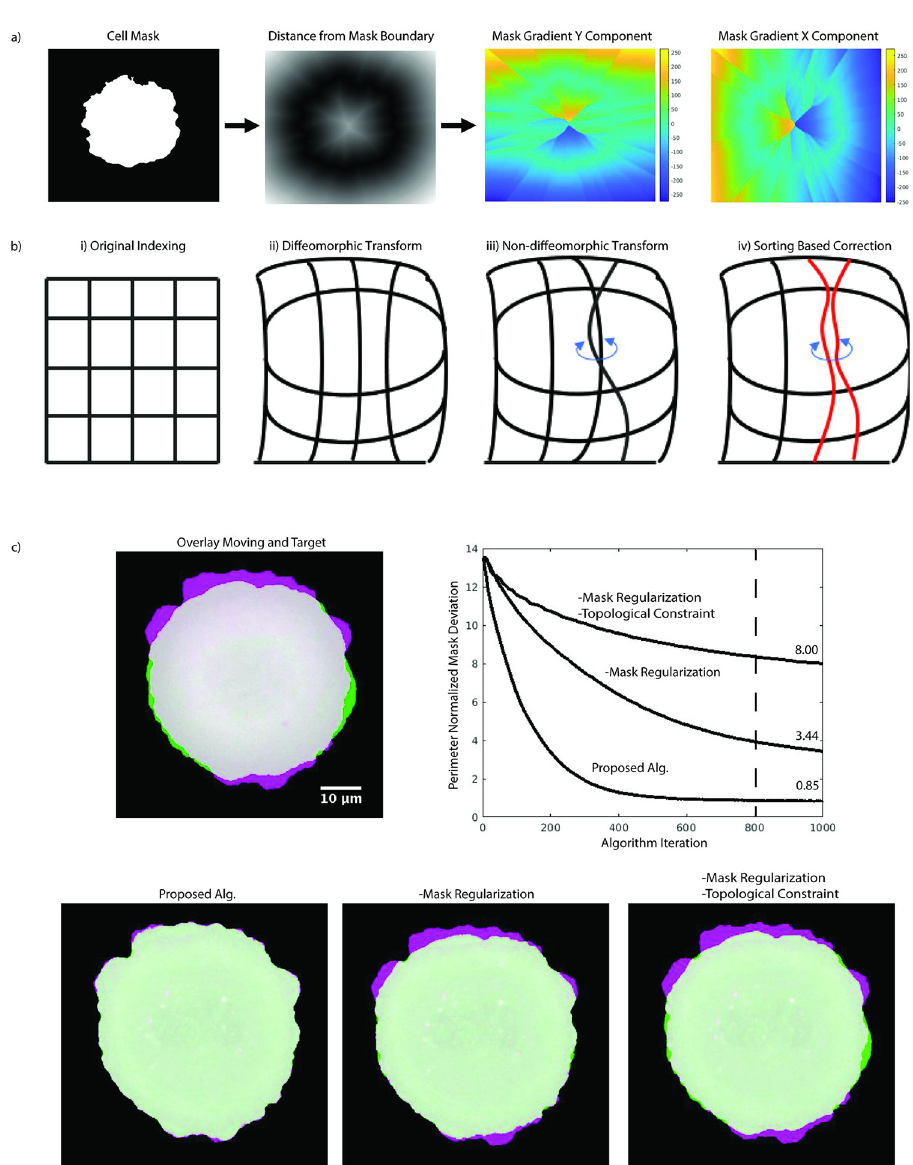
Fig 2. Computational elements for the remapping process. a) Extraction of the mask gradient r f mask . Based on a cell mask, we calculate for each pixel the distance to the nearest cell boundary element for both the cell-interior and cell- exterior spaces. The gradient on this distance field defines r f mask . b) Diffeomorphism constraint. From left to right, illustrations of interpolation fields, where edges indicate the sampling position of an input image to remap onto a target. The mesh diagram shows displacements as deviation from a square mesh (1 st diagram from left). A diffeomorphic transform (2 nd diagram) is represented by a deformed mesh. A break in diffeomorphism (3 rd diagram) is represented by crossings of mesh edges. By sorting the mesh coordinates in sequential order, breaks in diffeomorphism can be reverted (4 th diagram). c) Effect of algorithm components on cell edge registration. Accuracy of registration over n iterations is indicated by the area of mismatch (green and purple) between the moving cell and the target cell image, normalized by the target cell perimeter. Removing the mask regularization and topological constraint enforcing diffeomorphism reduces both the rate of convergence and the final accuracy. The dashed line indicates the iteration stop for a visualization of the registration results (bottom row). The proposed algorithm gives a near pixel perfect registration of the two images. Removing the mask regularization largely reduces the rate of convergence. Removing both mask regularization and topological constraint causes failure in the capture of small